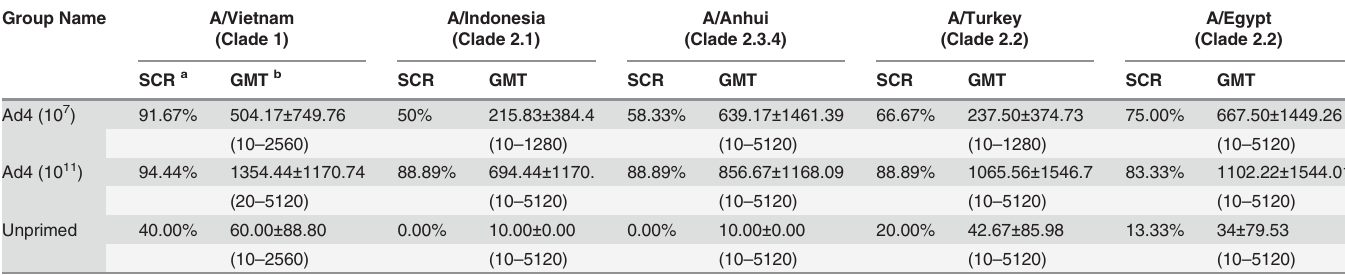
Table 1. Geometric Mean and Standard deviations for the end-point microneutralization titers of three vaccine groups against diverse H5N1 virus strains. Group